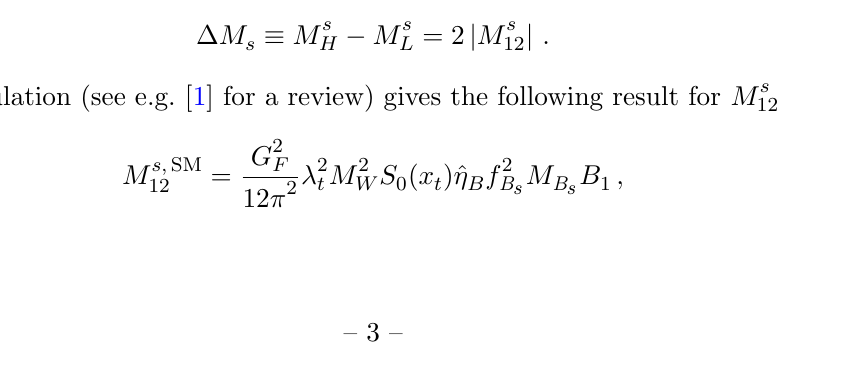
and (cid:1) M . See section 2 for s d